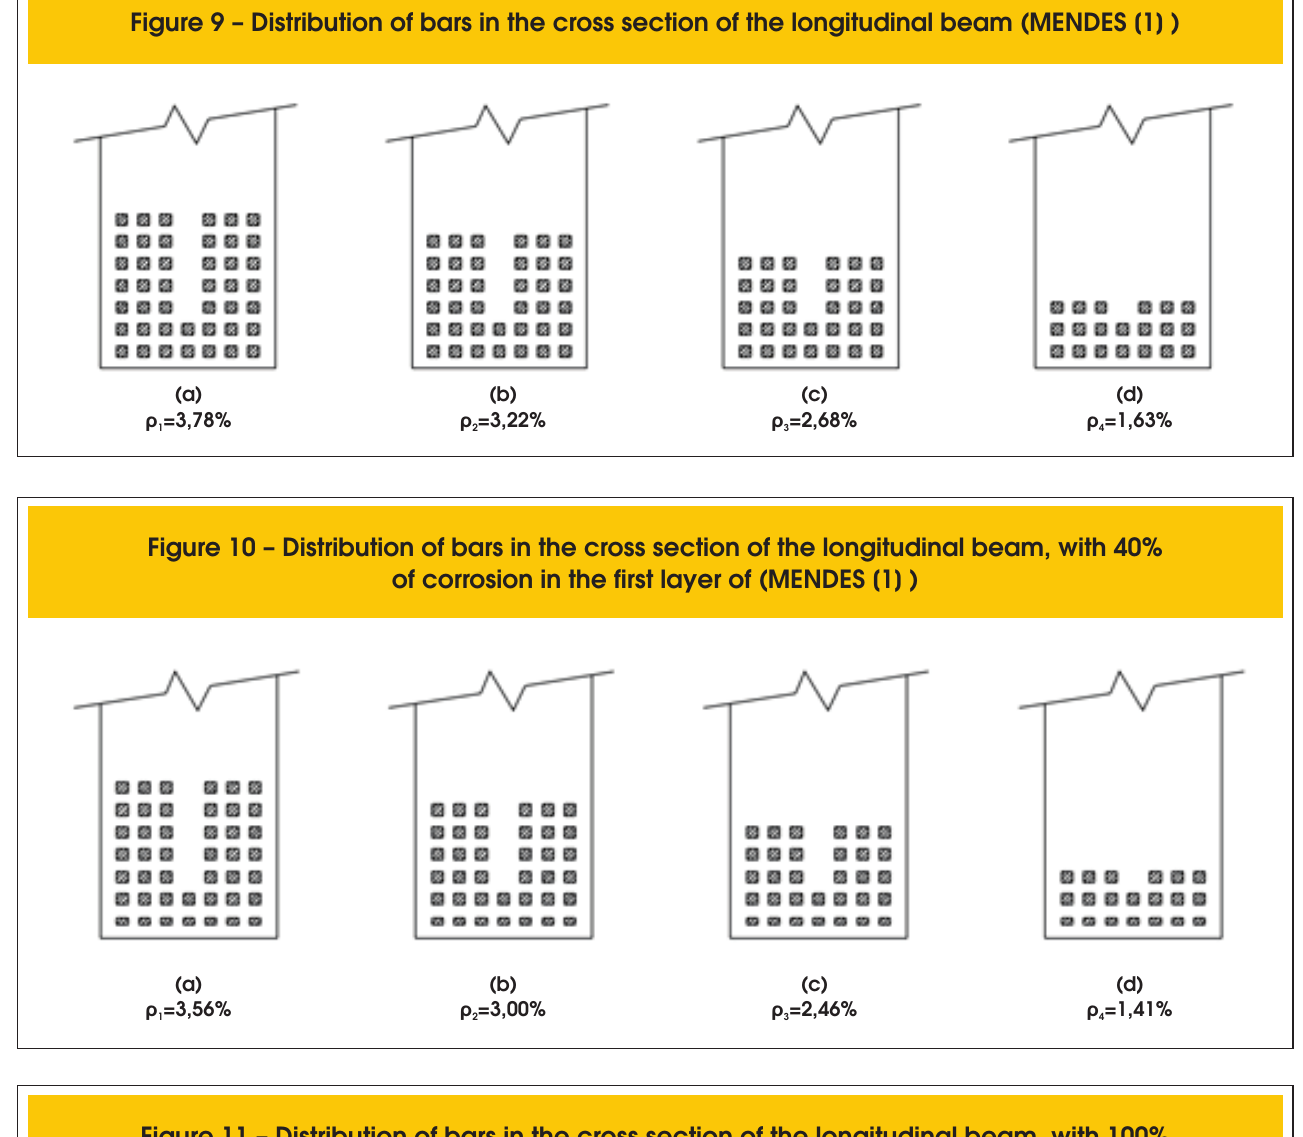
Figure 11 – Distribution of bars in the cross section of the longitudinal beam, with 100% of corrosion in the first layer (MENDES [1]